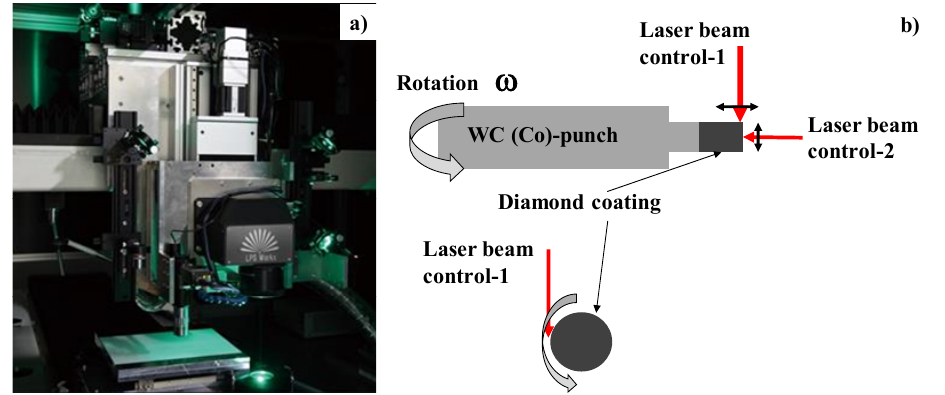
Figure 2. Femtosecond laser trimming experimental setup. ( a ) Femtosecond laser micro-machining system and ( b ) two-step laser trimming procedure.